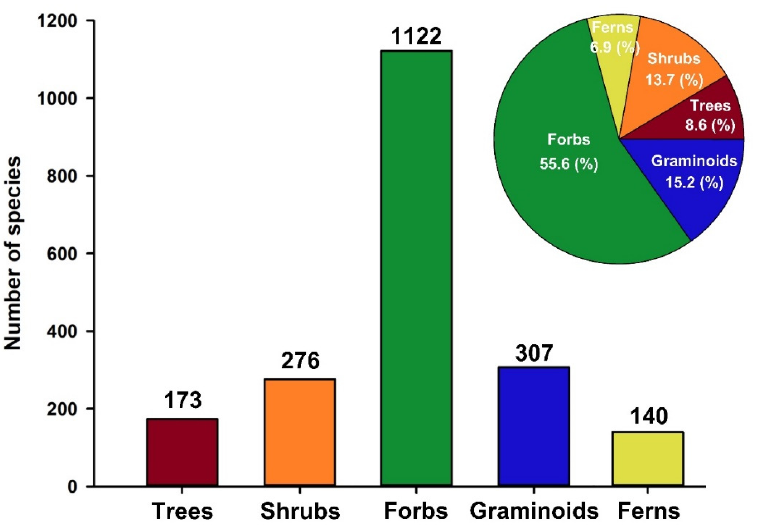
Figure 2. The number of species for woody (trees, shrubs) and herbaceous (ferns, forbs, graminoids) plants recorded on 578 islands. The graminoids were defined as grasses, sedges, and rushes.